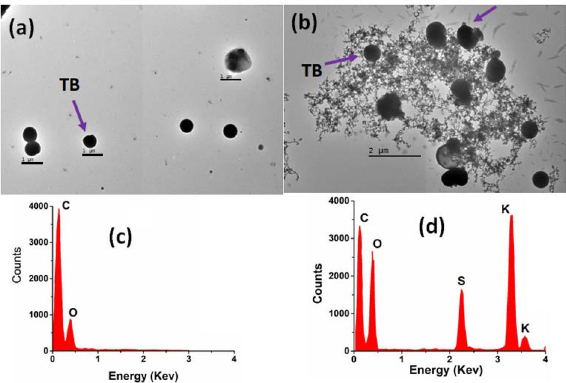
Figure 6. TEM images of the ( a ) TB and ( b ) Soot particles, and EDS spectra of: ( c ) TB and ( d ) soot particles sampled in MC.